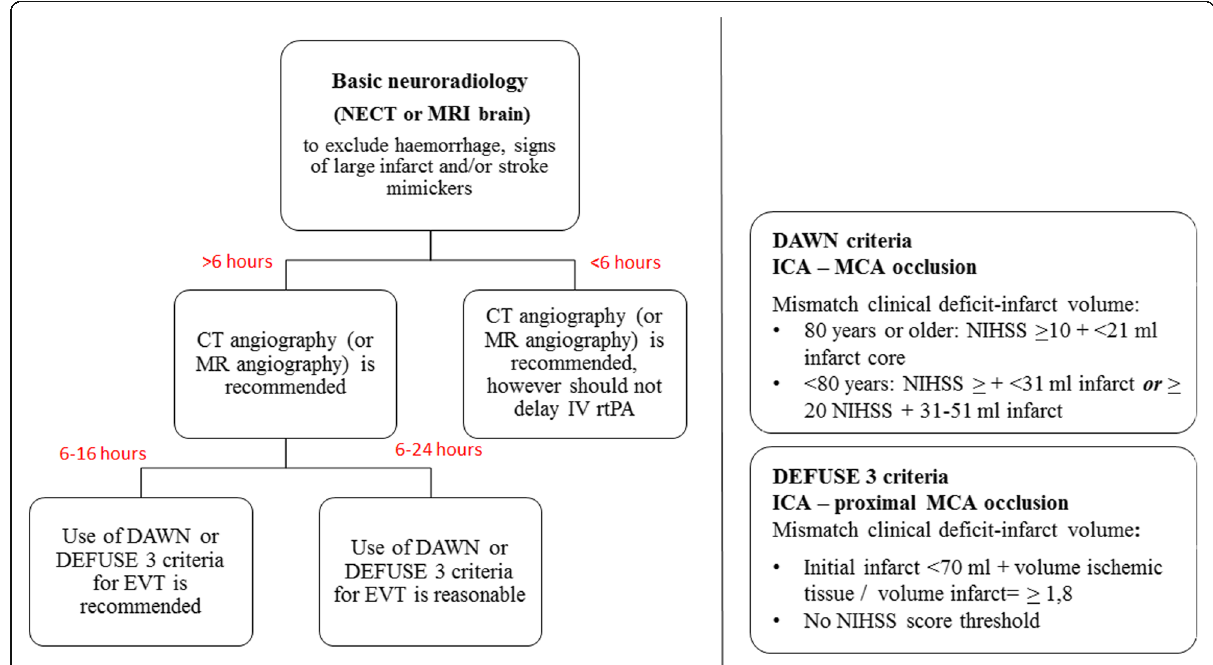
Fig. 4 Flowchart representing patients ’ selection criteria for EVT within 6 h and beyond the 6-h time window according to class I